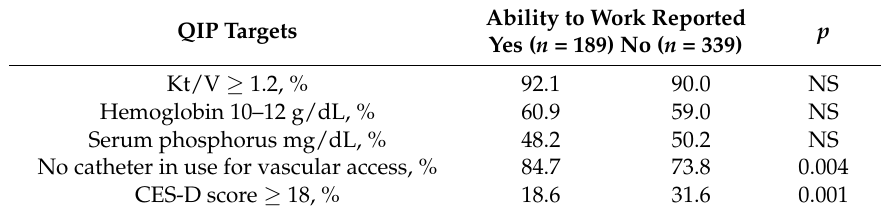
Table 3. Attainment of quality indicator goals: working-age ESKD patients on HD who reported ability to work and did not report ability to